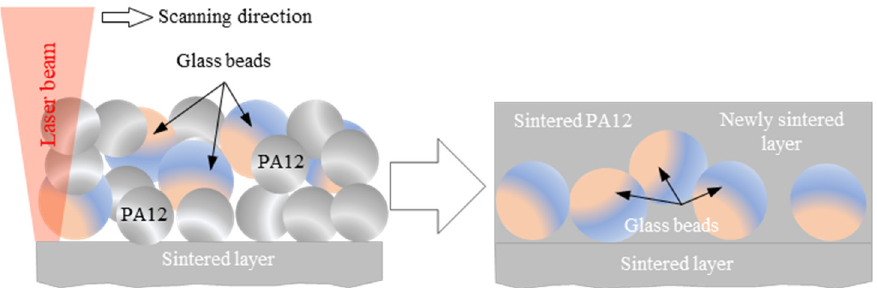
Figure 6. Possibility of glass bead precipitation in the sintered layer.